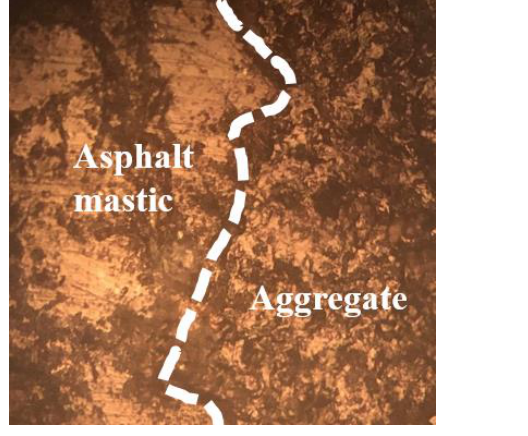
Figure 4. Typical aggregate-asphalt mastic interface under optical microscope. For each nanoindentation sample, 16 measurement points (4 × 4 matrix, measurement point interval 80 μm) were arranged in a clear and flat ar ea. Some micrographs of the test area and the distribution of measurement points are shown in Figure 5.